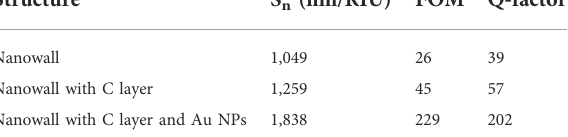
TABLE 2 Refractive index sensitivity, FOM, and Q-factor for the three proposed structures. Structure